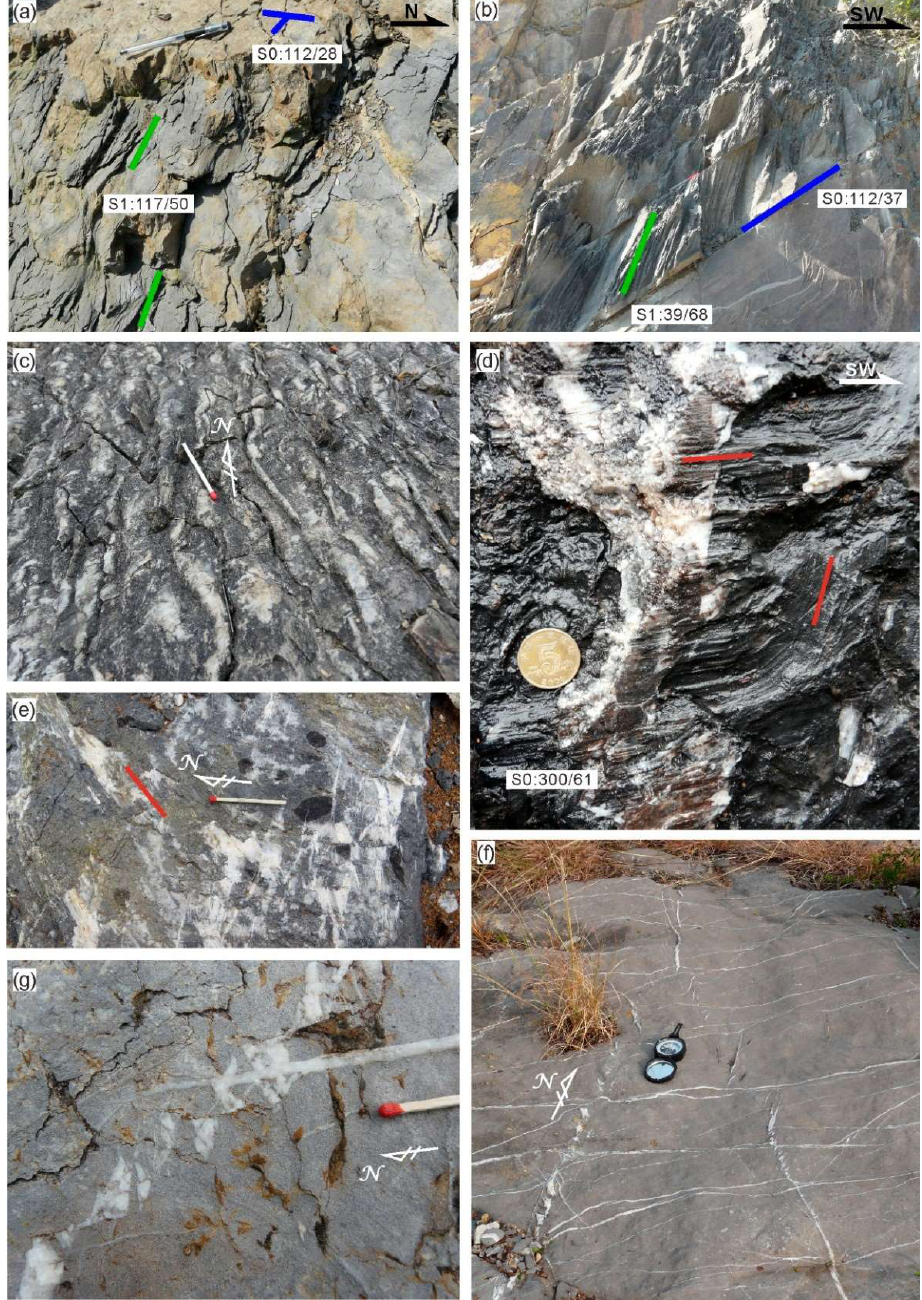
Figure 3. Field photographs of secondary deformation structures in the flanks of the Longshan Dome. ( a ) slaty cleavages within Middle Devonian marls and ( b ) slaty cleavages within Upper Devonian mudstone on the western flank, north of Cunshi village; ( c ) secondary folds of calcite veins subparallel to the bedding within Middle Devonian on the western flank, northeast of Cunshi village; ( d ) two sets of slickenlines, dip-parallel and strike-parallel, on a certain bedding-parallel fault within Middle Devonian marls at the location of sample H34, the former set turns gradually into the latter set; ( e ) spaced cleavages and bedding-perpendicular stylolites within Upper Devonian limestone on the northern flank, near Baima village; ( f ) two principal sets of calcite veins and ( g ) lenticular calcite veins cut through or abut by short stylolites within gen- tly-dipping, Lower Carboniferous limestone on the southern flank, near Hetianpu village.